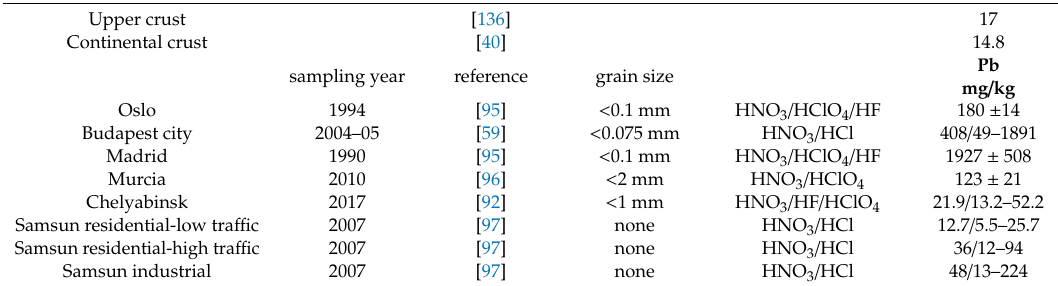
Table A35. Lead in road